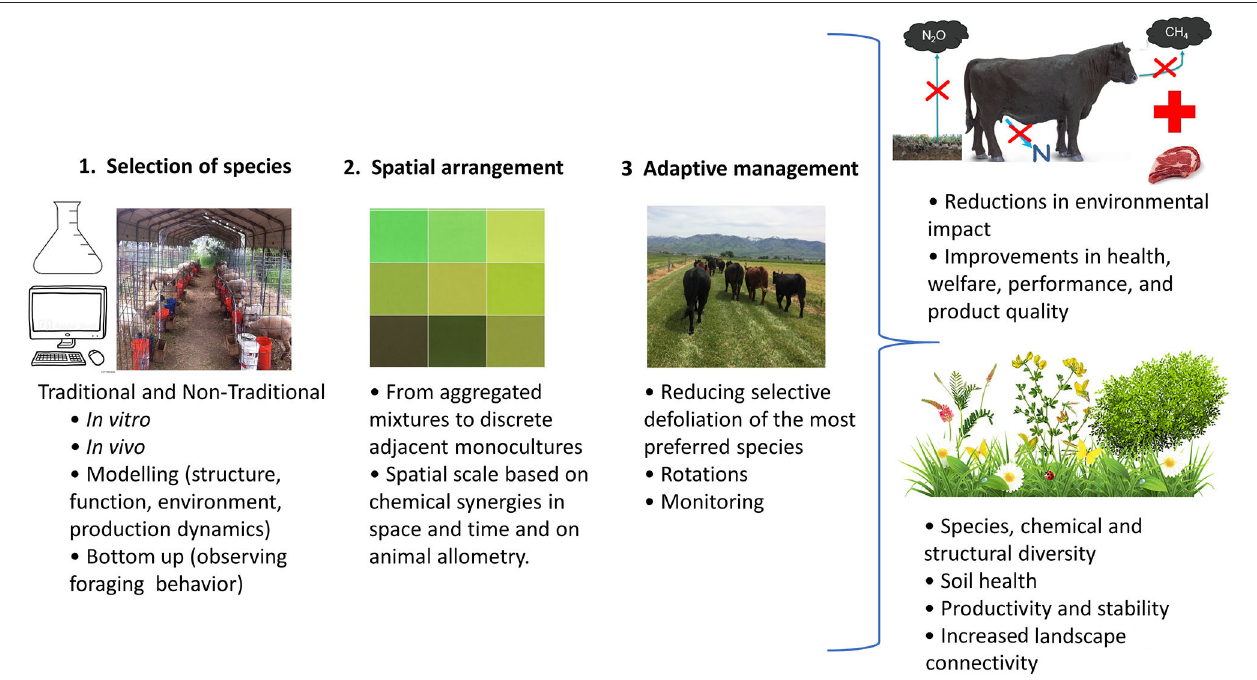
FIGURE 1 | Flow diagram for the design, benefit, and management of diverse, multifunctional pasture communities (expanded from Hobbs and Morton, 1999; Sanderson et al., 2007 ).